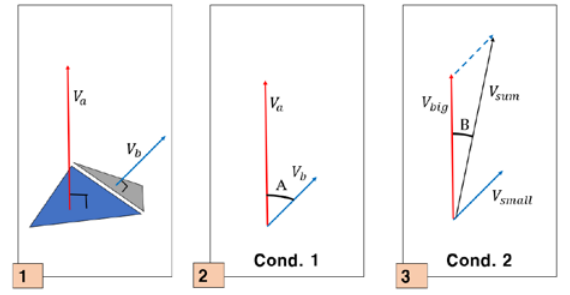
Figure 12. Illustration of threshold and angles.